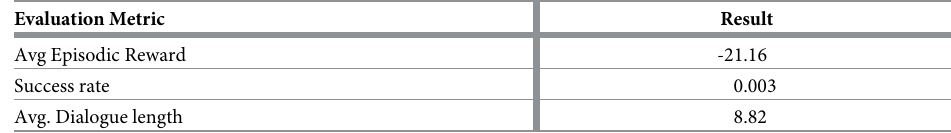
Table 9. Performance of the SimpleDS for dynamic goal setting.